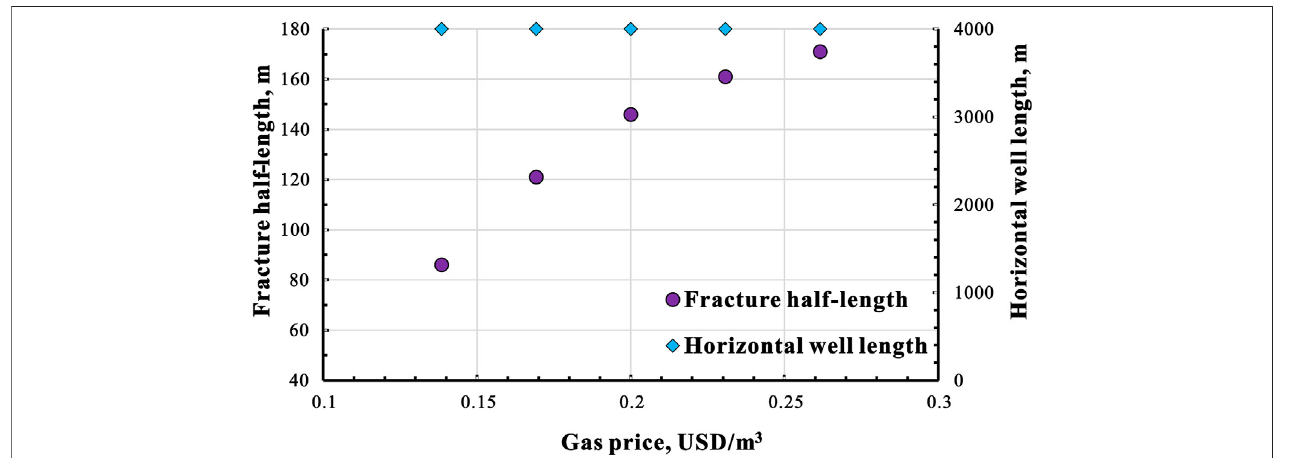
FIGURE 8 | Relationship between optimal fracture half-length, horizontal well length, and gas